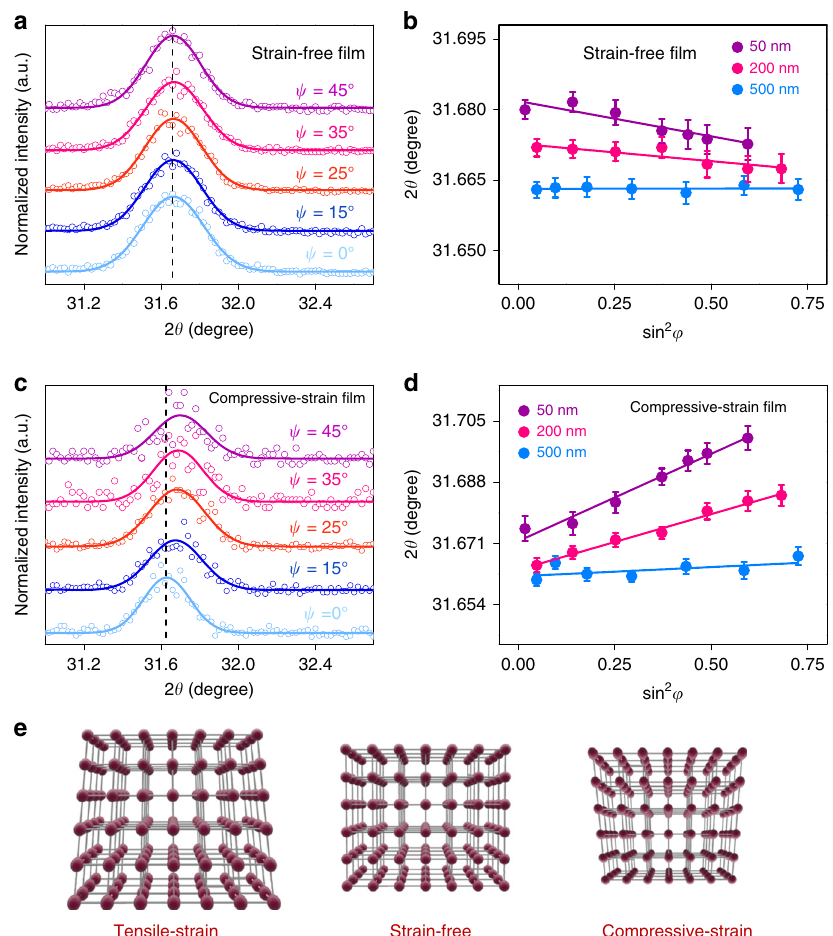
Fig. 2 Residual strain distribution measurement with the GIXRD method. a , c GIXRD spectrum at different tilt angles at the depth of 50 nm for the strain- free fi lm, compressive strained fi lm. b , d Residual strain distribution in the depth of 50, 200, 500 nm for the strain-free fi lm, compressive strained fi lm (measured (points) and Gauss fi tted (line) diffraction strain data as a function of sin 2 φ ). The error bar indicates standard deviation of the 2 θ . e The schematic representation of the tensile strain state of the fi lm in the top surface, showing the lattice structure with/without tensile strain on the fi lm surface from the perspective of long-range